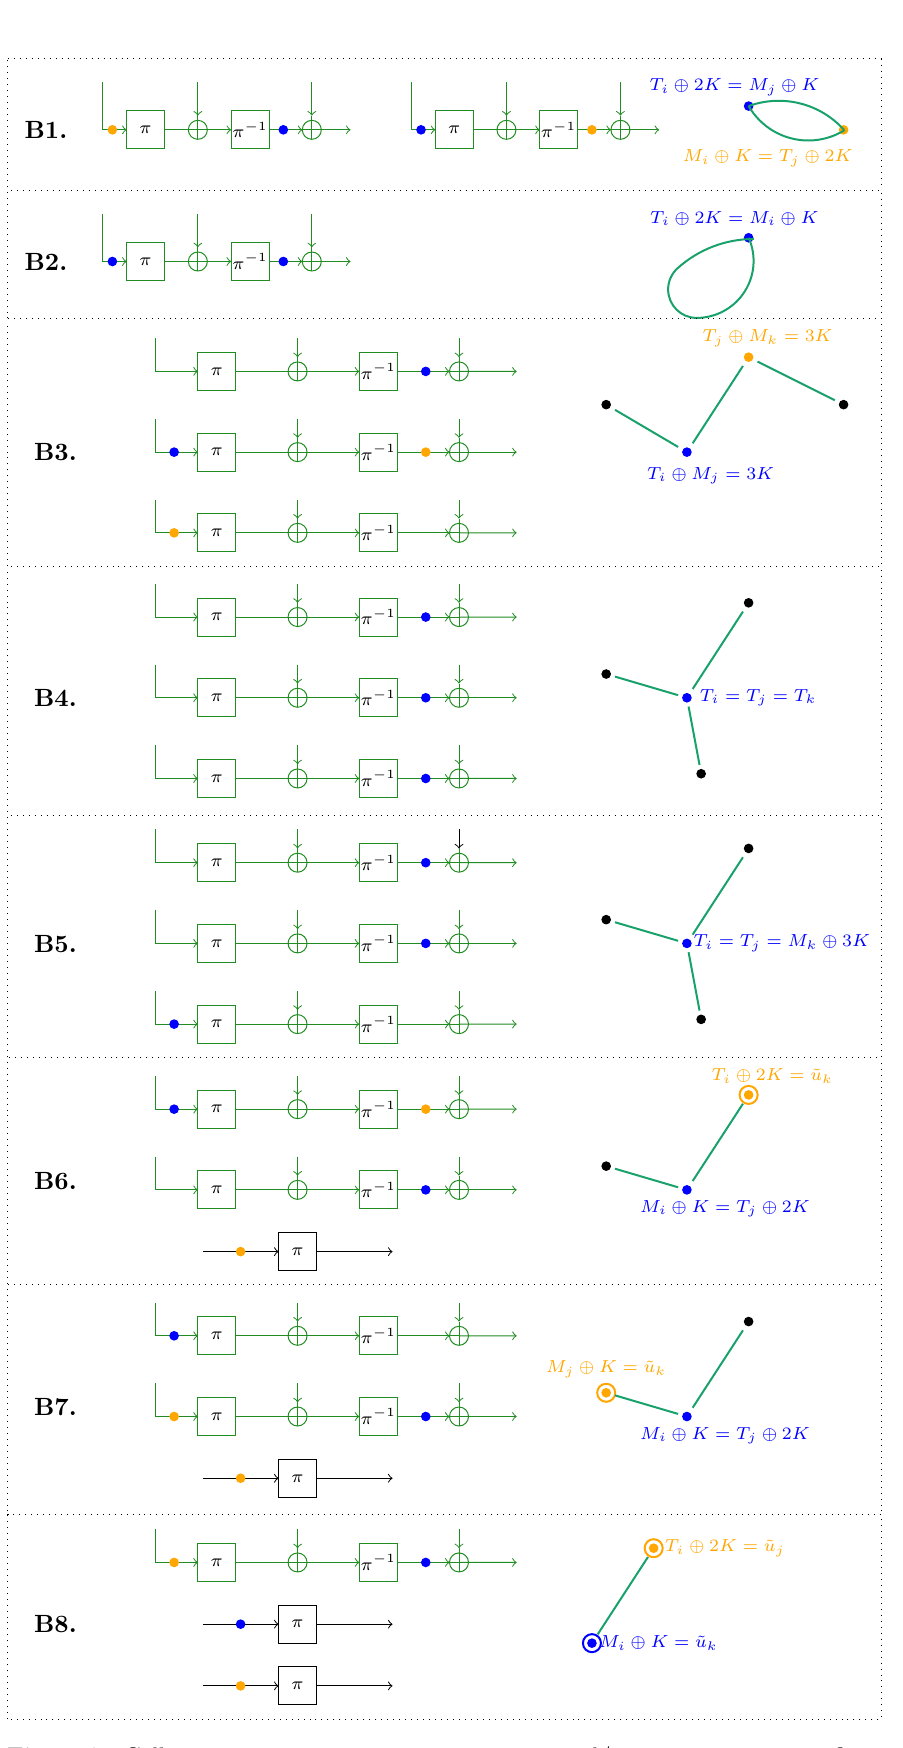
Figure 7: Collisions amongst construction equations and/or primitive queries - figurative and graphical representations of the bad